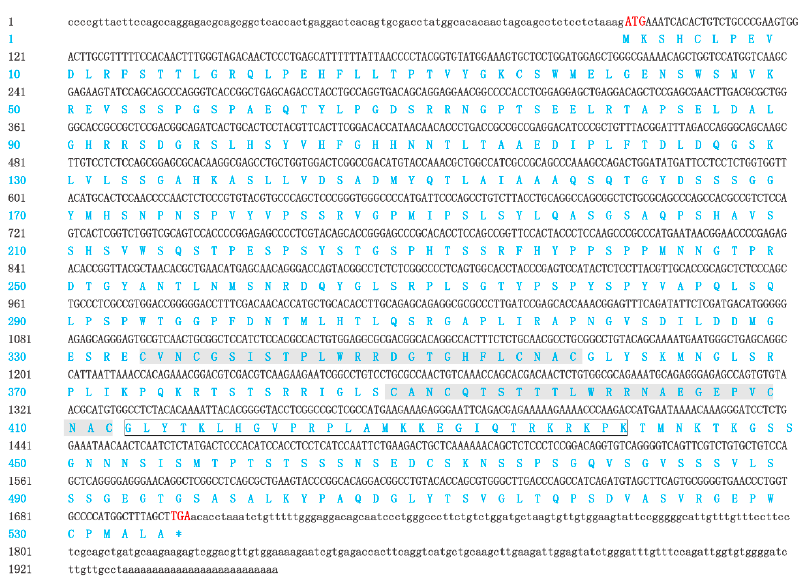
Figure 1. Nucleotide and deduced amino acid sequences of P. olivaceus GATA6. Nucleotides are indicated in black and the amino acids in blue. Initiation codon and termination codon are in red. UTRs (Untranslated Regions) and ORF (Open Reading Frame) are denoted in lowercase and uppercase letters, respectively. The zinc finger domains are shaded, whereas the nuclear localization sequence is boxed.